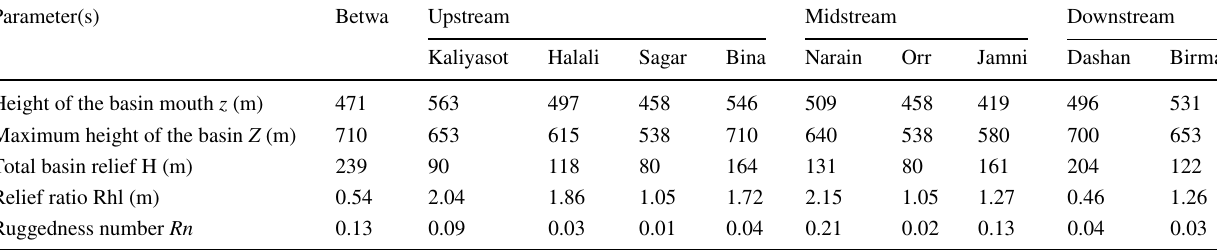
Table 6 Relief characteristics of Betwa River basin and sub-basins